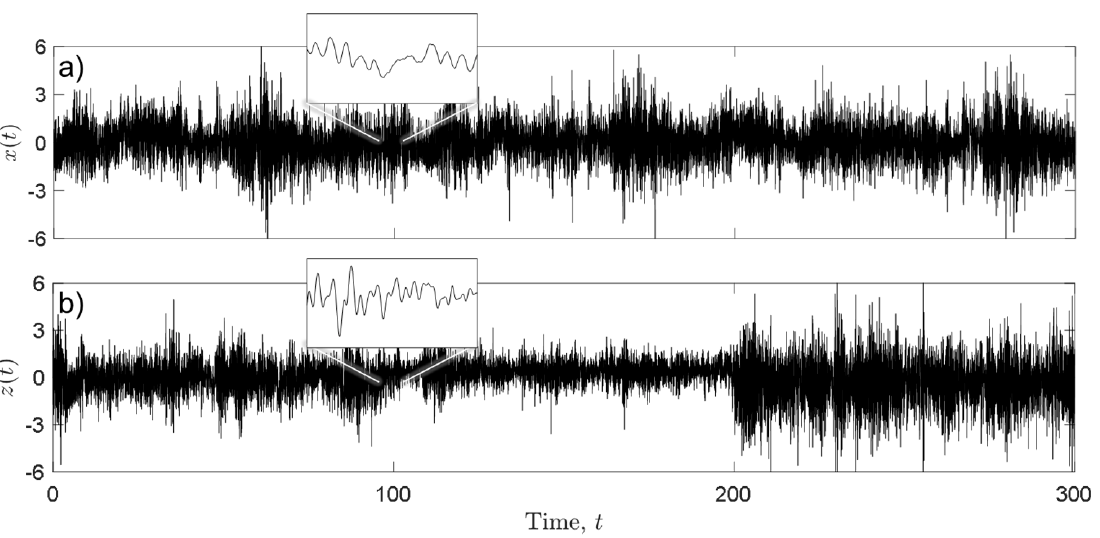
Figure 8. Overall and zoom view of measured load records: ( a ) stationary and ( b ) non-stationary.